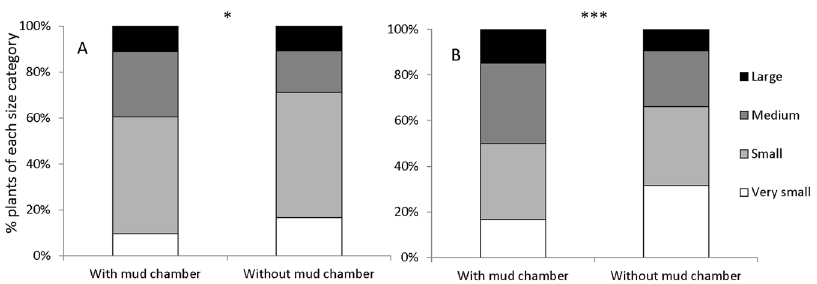
Figure 4. Relationship between presence of mud chamber and plant-size distribution (based on canopy diameter, very small: 0–5 cm; small: 5–10 cm; medium: 10–20 cm; large: more than 20 cm) in the first survey in August ( A ), and the second survey in December ( B ). Plants with a mud chamber were more likely to be of the larger size categories (see text for